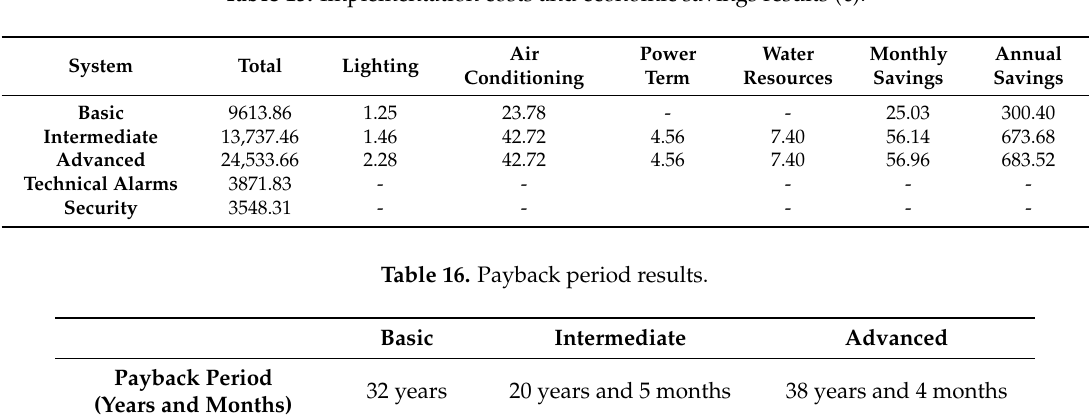
Table 15. Implementation costs and economic savings results ( € ).